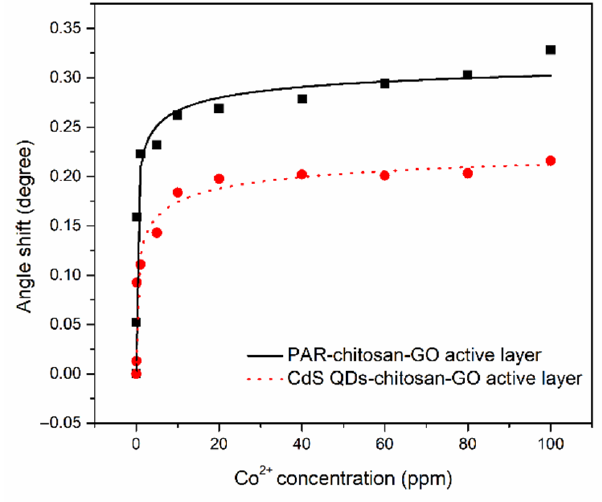
Figure 5. SPR angle shift comparison (fitted with Sips model) between PAR–chitosan–GO and CdS QD–chitosan–GO thin films in contact with different concentration of Co 2+ from 0 to 100 ppm. Table 3. The calculated fitting parameters using Langmuir–Freundlich models. Sample K (ppm − 1